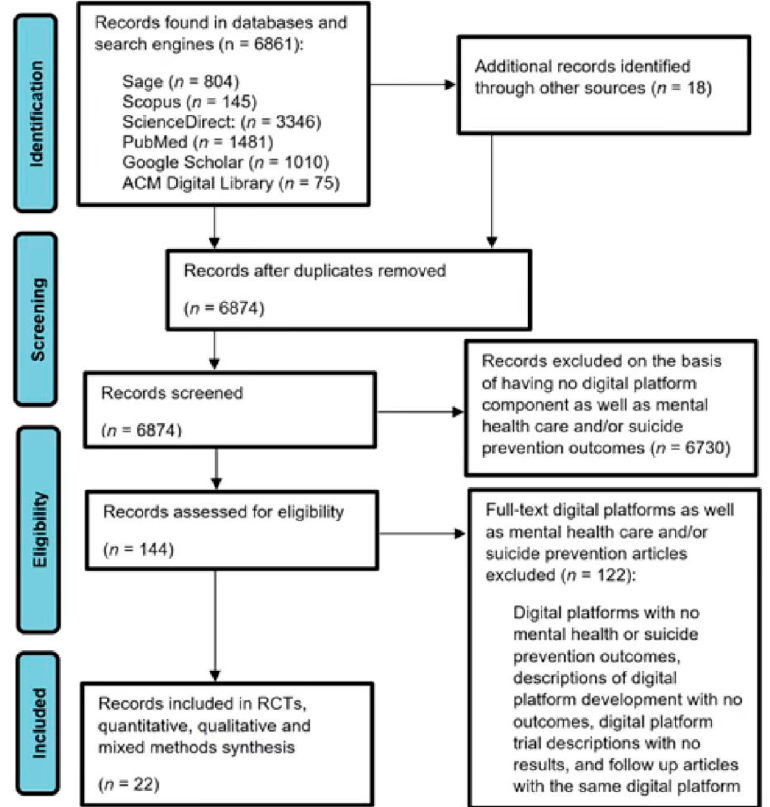
Figure 1. Flowchart of the study selection procedure.